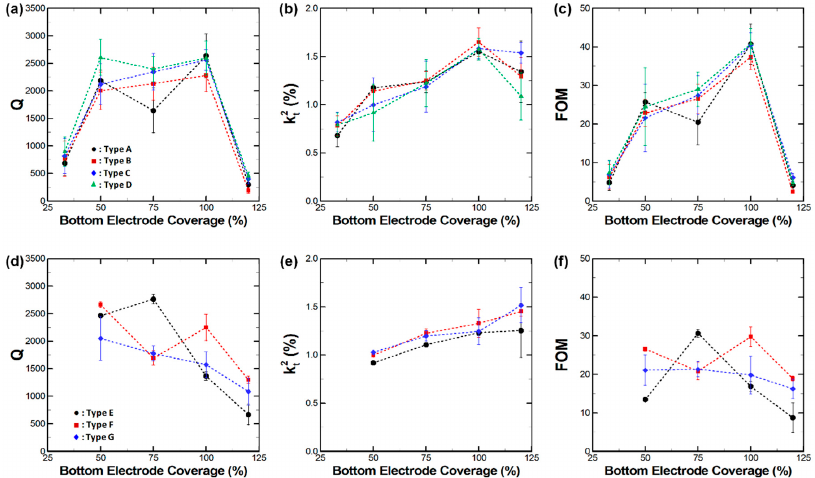
Figure 4. Measured electromechanical properties of ( a – c ) 230 MHz and ( d – f ) 1.1 GHz CMS with varying bottom electrode coverages. It is clear that both the quality factor ( Q ) and electromechanical coupling ( k 2 ) of CMRs depend on the bottom electrode designs, ultimately a ff ecting the device figure of merit